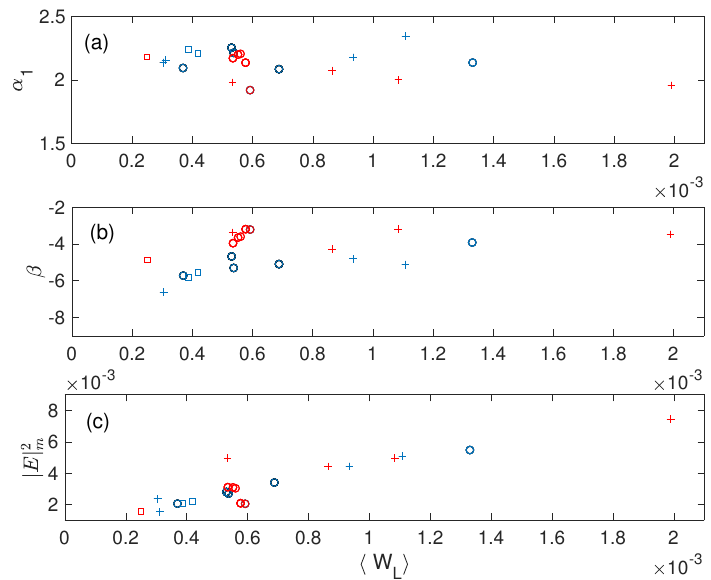
Figure 24. ( a – c ) Characteristic parameters α 1 , β and | E m | 2 of the PDFs of the Langmuir field amplitudes | E | , as a function of the averaged levels of Langmuir turbulence (cid:104) W L (cid:105) and of density fluctuations: ∆ n (cid:39) 0.01 (crosses), ∆ n = 0.02 (circles) and ∆ n = 0.03 (squares). The red (blue) markers indicate that the decay instability does not play (plays) an essential role in the corresponding simulations. All variables are normalized. (Reproduced with permission from [73]).